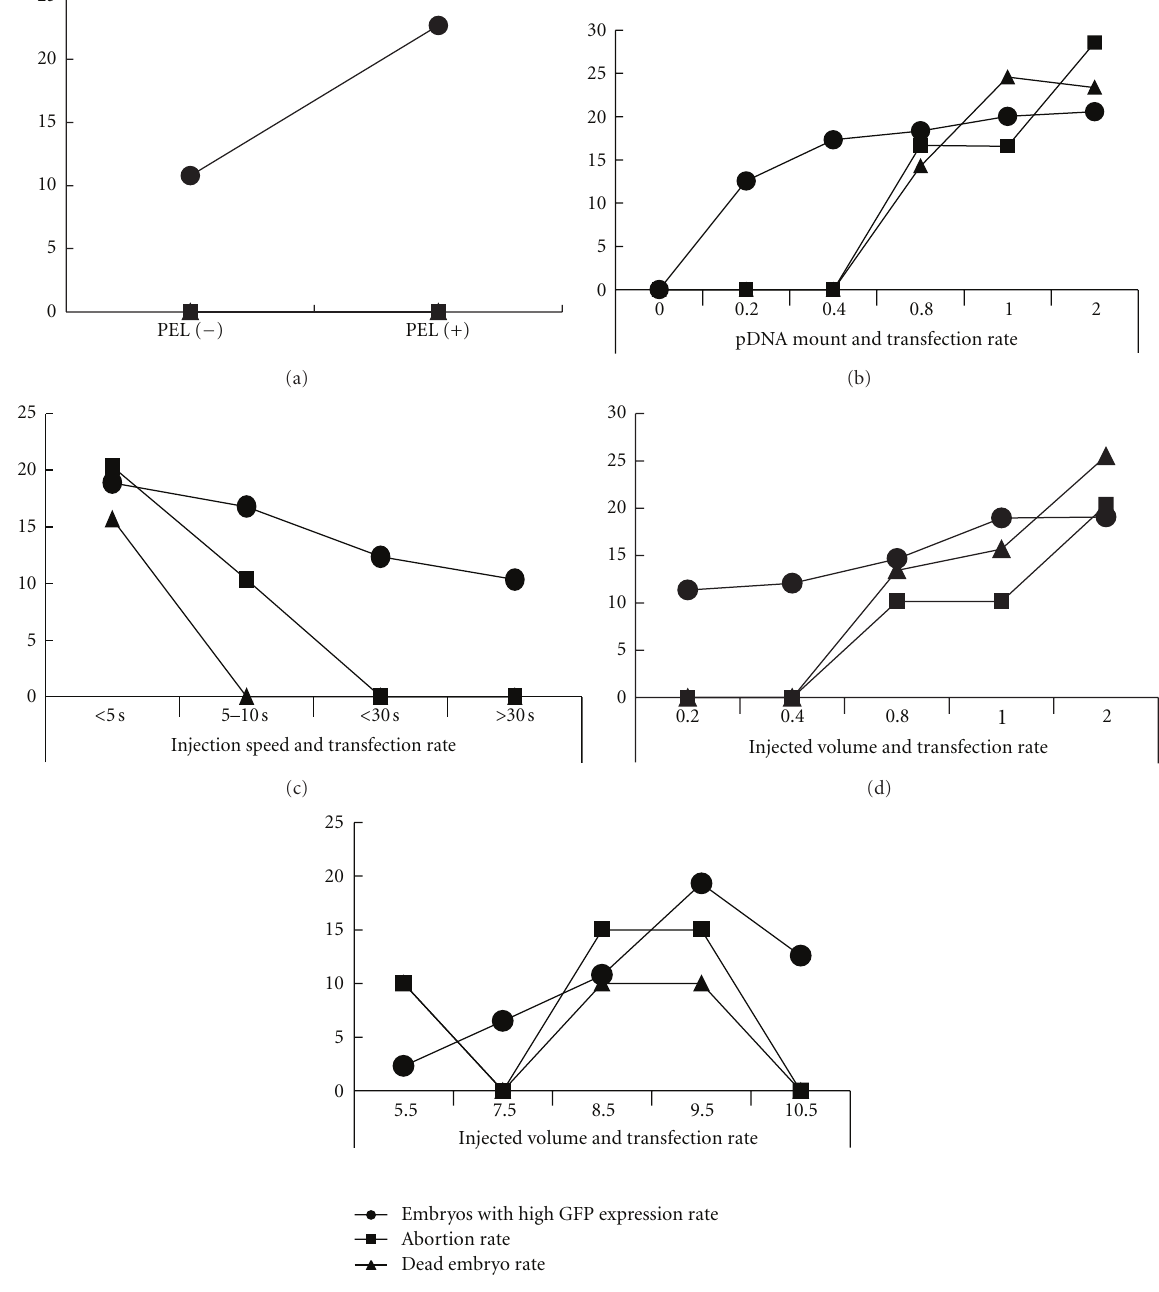
Figure 3: Factors a ff ecting the shRNA deliver e ffi ciency and toxicity on developing embryos in vivo. shRNA vector transfection rate was measured by GFP expression level, and the toxicity was assessed by pregnant mice abortion rate and dead embryo rate. GFP expression level and dead embryo rate were detected after treatment with plasmids for 48h, and pregnant mice abortion rate was detected at 48h after injection. (a) Amount of PEI a ff ects pDNA transfection rate and toxicity. 0.8mg of pSilencer4.1/Sry565 plasmid mixed with same amount of (PEI+) or without PEI (PEI − ) diluted in 1.0 mL 5% glucose solution was injected into 9.5dpc pregnant mice tail vine in 10 seconds. (b) E ff ect of pDNA amount on transfection rate and toxicity. Certain amount of pSilencer4.1/Sry565 plasmids mixed with PEI, diluted in 1.0 mL of 5% glucose solution, were injected into 9.5dpc pregnant mice tail vine in 10 seconds. (c) E ff ect of injection speed on transfection rate and toxicity. Pregnant mice at 9.5 dpc were intravenously injected with 0.8 mg of plasmid DNA and PEI complex in 1.0 mL saline. The injection time was varied from 5 to 30s. (d) E ff ect of injection volume on transfection rate and toxicity. 0.8 mg of plasmid DNA and PEI complex was diluted in 0.2 to 2.0mL 5% glucose solution and injected into pregnant mice at 9.5 dpc. (e) E ff ects of injection time on transfection rate and toxicity. 0.8 mg of plasmid DNA and PEI complex was diluted 1.0 mL 5% glucose solution and injected into pregnant mice various at 5.5dpc to 10.5 dpc. GFP expressions in embryos and dead embryo rate were detected at 11.5 dpc. Pregnant mice abortion rate was measured in 48 h after